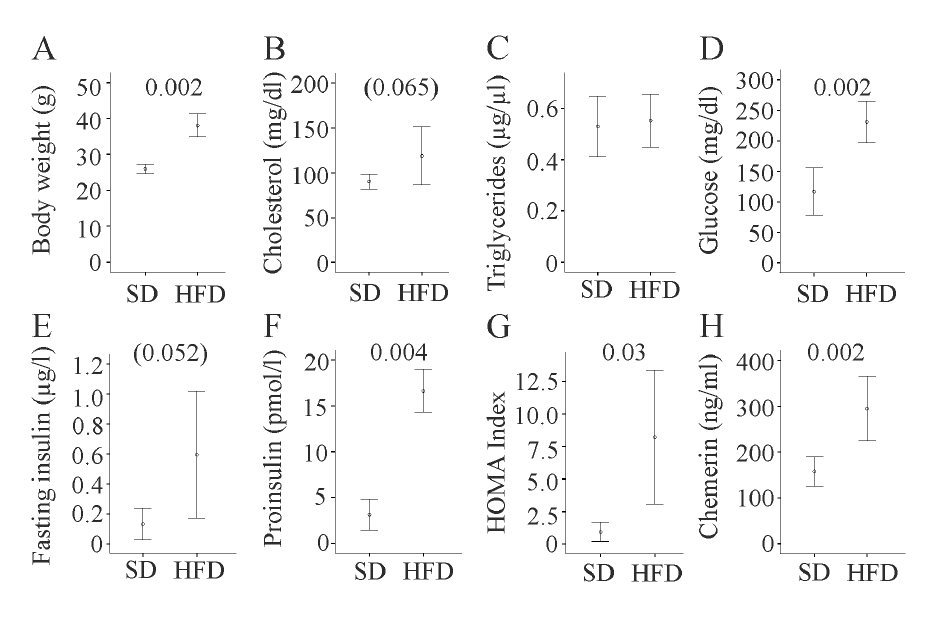
Figure 1. Metabolic parameters of C57BL/6 mice fed a standard chow (SD) or a high